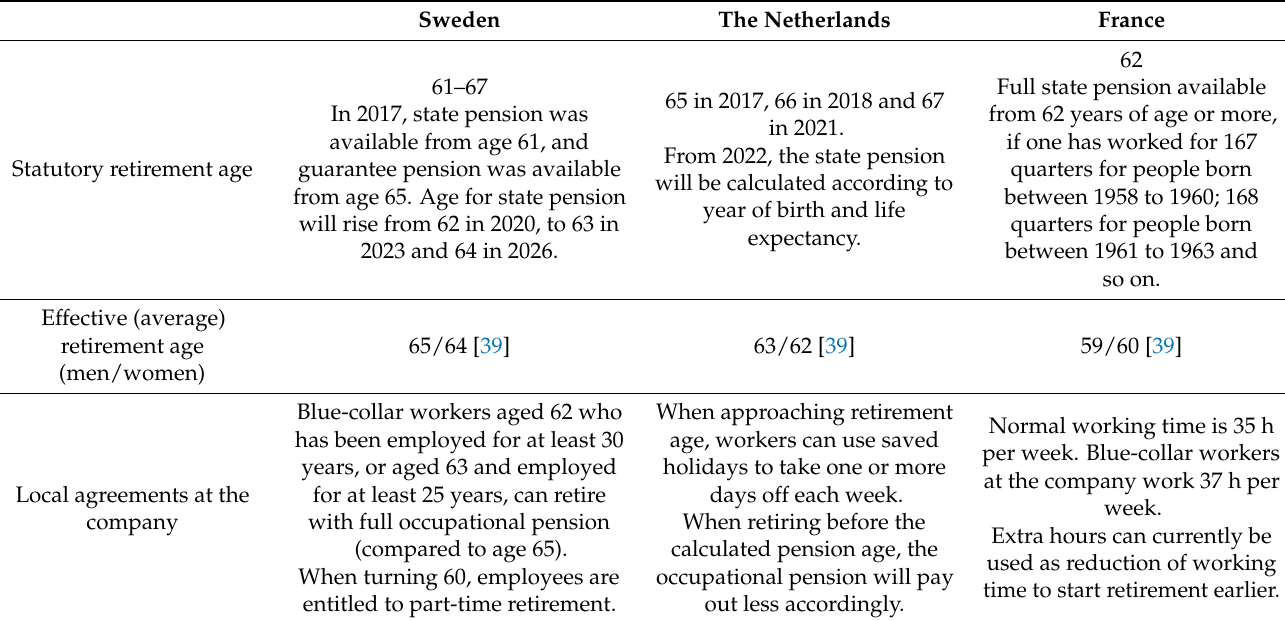
Table 1. Pension systems and local agreements in the different